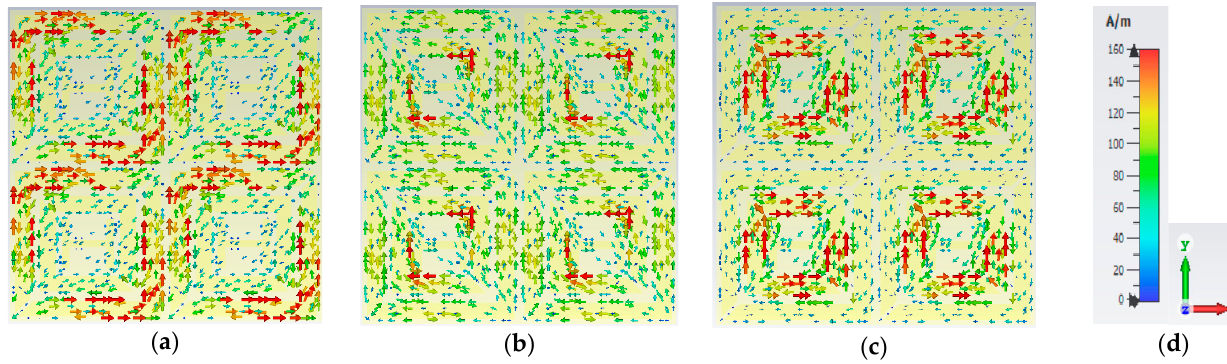
Figure 9. Surface current at ( a ) 6.24 GHz; ( b ) 10.608 GHz; ( c ) 18.624 GHz. ( d ) Scale and axis.